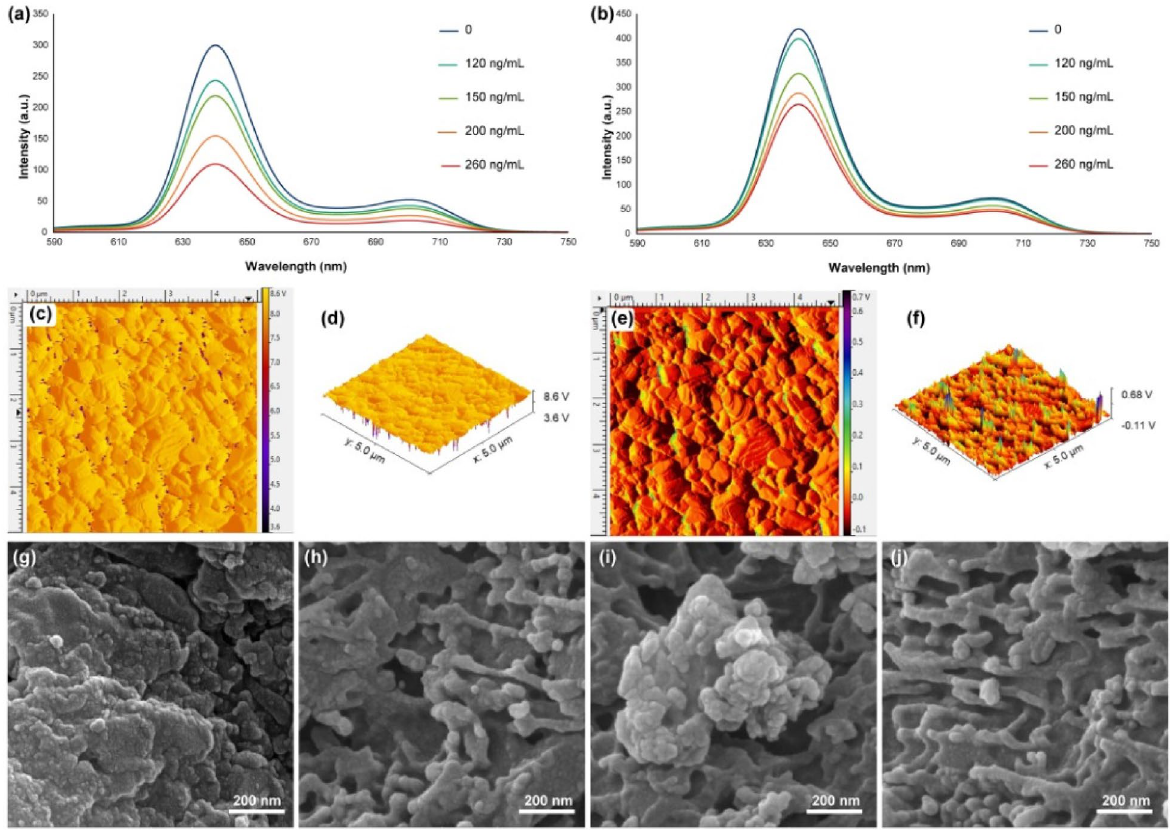
Figure 4. Fluorescence emission spectra of the synthesized 3D nanocomposite in the presence of different concentrations of PMA added to the HEK-293 ( a ) and PC12 ( b ) cell lines. 2D ( c ) and 3D ( d ) AFM images and ( g and h ) FESEM images of the synthesized 3D nanocomposite after removing from the PC12 culture and exposure to the hydrogen peroxide; 2D ( e ) and 3D ( f ) AFM images and ( i and j ) FESEM images of the synthesized 3D nanocomposite after removing from the HEK-293 culture and exposure to the hydrogen